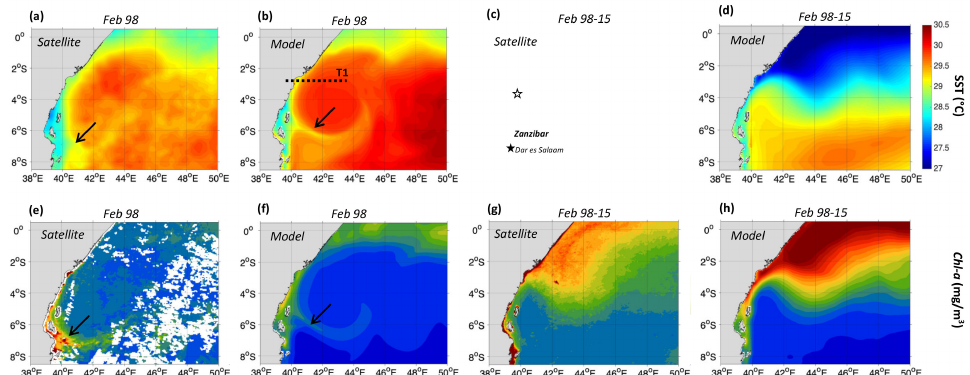
Figure 1. The surface signature of the North Kenya Bank (NKB) upwelling during February 1998, relative to the climatology (1998–2015). SST ( ◦ C) in February 1998 from ( a ) satellite data and ( b ) the model is shown, relative to ( c , d ) their climatological means. Chl-a (mg / m 3 ) in February 1998 from ( e ) satellite data and ( f ) the model is shown, relative to ( g , h ) their climatological means. The black arrows on ( a ), ( b ), ( e ) and ( f ) indicate the position of the relatively cool and high Chl-a tongue south of Zanzibar o ff Dar es Salaam. The dotted horizontal line (T1) displayed on panel ( b ) indicates the position of a cross-section across the NKB upwelling analyzed in Figure